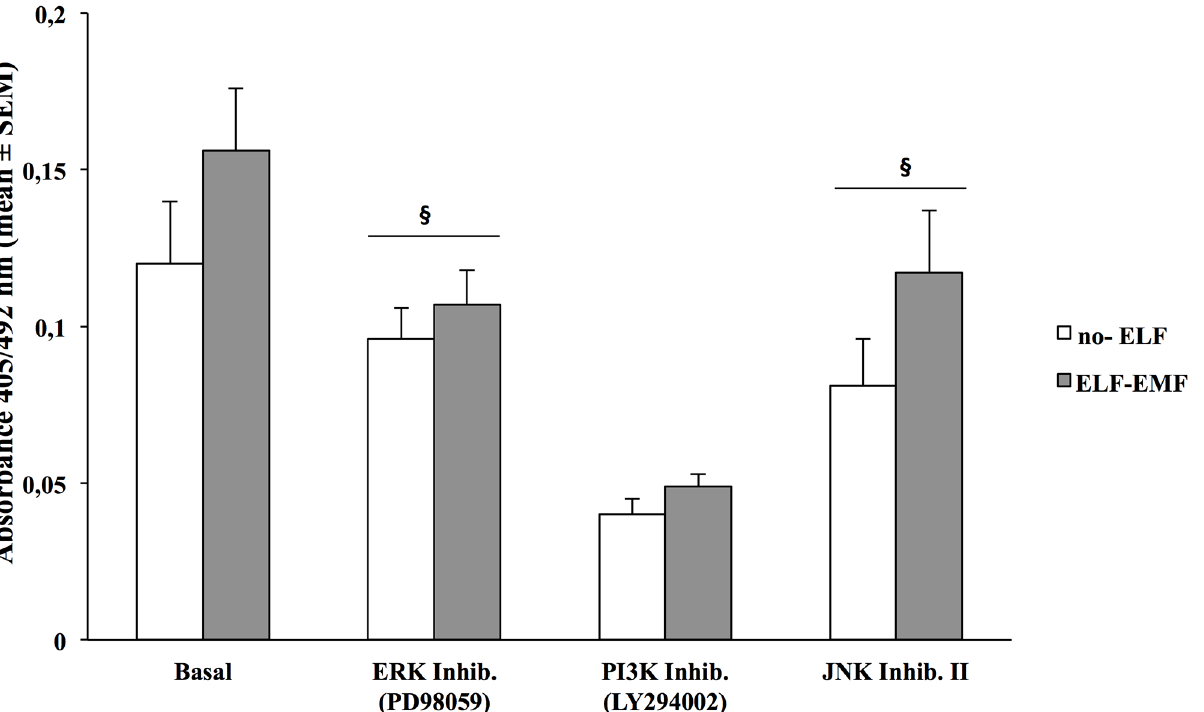
Fig 3. Effects of pharmacological inhibitors on HaCaT cells proliferation. Proliferative rate of HaCaT cells assed by BrdU incorporation assay, after 24 h of incubation in non-exposed and exposed to ELF-EMF only for the first hour. Cells were pre-treated or not with selective inhibitor of ERK kinase